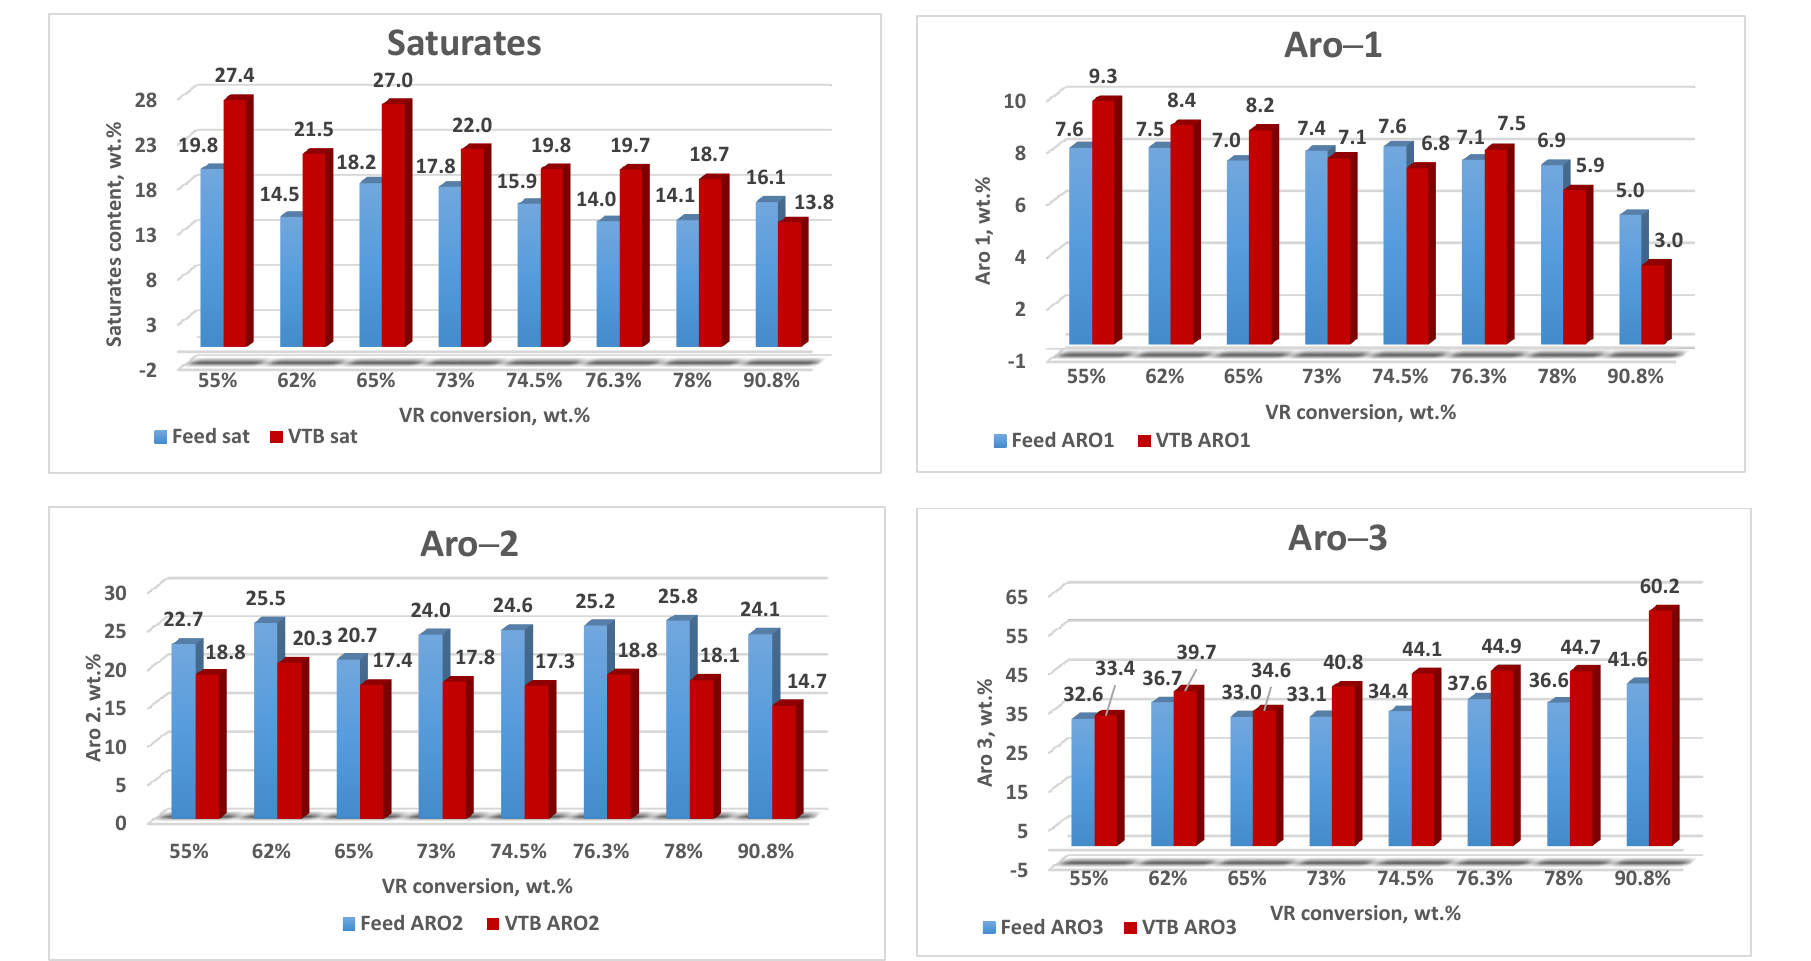
Figure 21. Variation of Saturates, Aro-1, Aro-2, and Aro-3 content in the H-Oil VTBs with conversion alteration, juxtaposed against these SAR-AD components in the feeds.